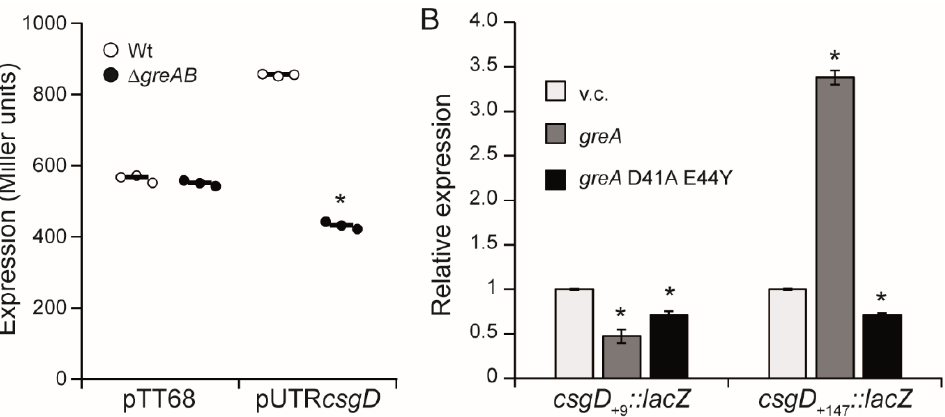
Figure 5. A Gre dependent transcriptional pause is located in the 5 ′ -UTR of the csgD gene. ( A ). lacZ expression from plasmid construct (pUTR csgD ) carrying the 5 ′ -UTR of csgD cloned in pTT68 vector downstream of the PBAD promoter and upstream of a promoter less lacZ gene in both Wt and Δ greAB strains. Cultures were grown in LB supplemented with ampicillin and arabinose at 37 °C up to an OD 600nm of 2.0. ( B ). Expression from the chromosomal fusions csgD +9 ::lacZ (lacking the 5 ′ -UTR) and csgD +147 ::lacZ (carrying the 5 ′ -UTR) in the Δ greAB strain carrying the plasmids pHM1883 (vector control, v.c.), pHM1873 (pHM1883 + greA MG1655 ) and pHM1854 (pHM1883 + greA MG1655(D41AE44Y) . Cultures were grown on LB 0 plates supplemented with spectinomycin and incu- bated at 28 °C for 48 h. A bar shows the arithmetic mean of experimental results and the error bar indicate the standard deviation from three biological replicates. Statistical significance to Wt is shown by an asterisk ( p < 0.0005).